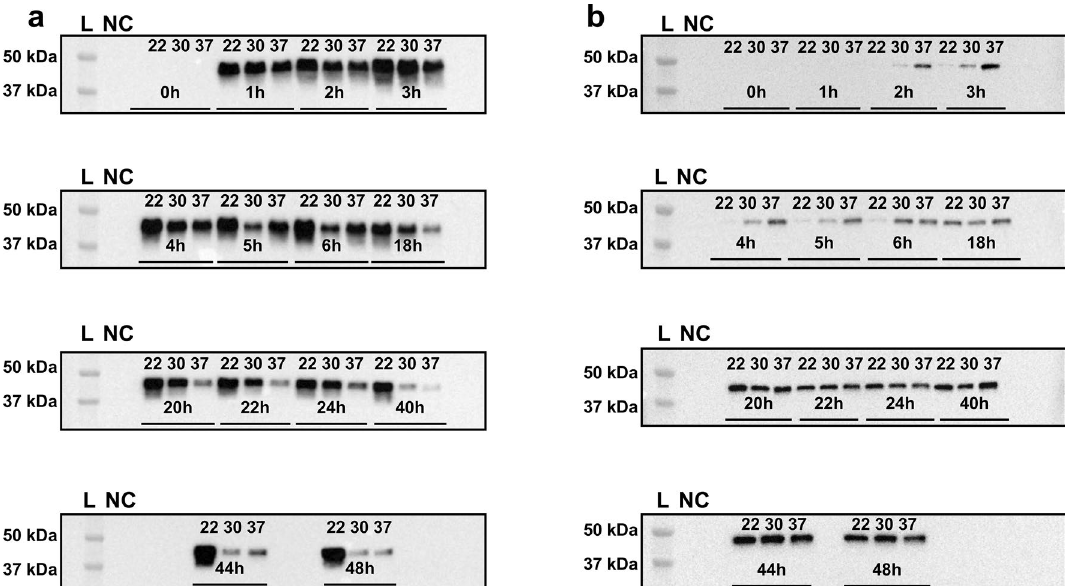
Figure 1. Protein expression of human HGD was evaluated in both E. coli BL21 (DE3) ( a ) and E. coli C43 (DE3) ( b ) strain and for different expression temperatures (22 °C, 30 °C and 37 °C) by western blot analysis to select the appropriate strain and temperature for reliable expression of human HGD. For both E. coli strains, a molecular weight band at 49 kDa was observed. Human HGD expression was higher in E. coli BL21 (DE3) compared to E. coli C43 (DE3). In E. coli BL21 (DE3), an obvious band at the expected molecular weight was observed for the three assessed temperatures from one hour after IPTG addition onwards ( a ). For E. coli C43 (DE3), a subtle band at the expected molecular weight was visible two hours post-IPTG addition and became more prominent after 20 h, but protein expression was still found to be lower compared to E. coli BL21 (DE3). The latter confirms a lower and more delayed protein expression at the three evaluated temperatures ( b ). Uncropped blots are available as Supplementary Information in Supplementary Fig. S1a (for E. coli BL21 (DE3)) and Fig. S1b (for E. coli C43